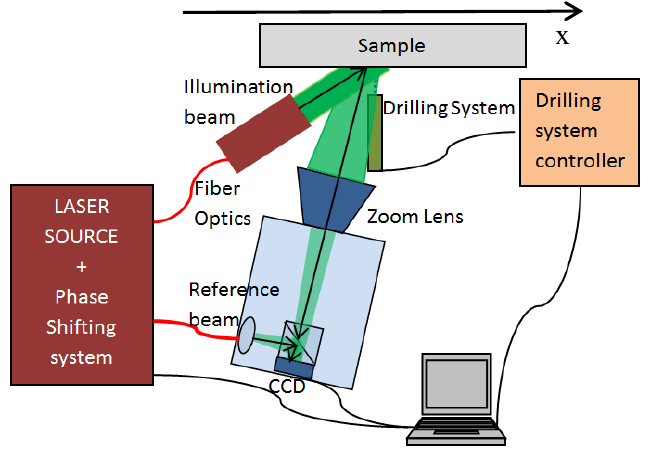
Figure 1: Experimental set-up for ESPI+HDM